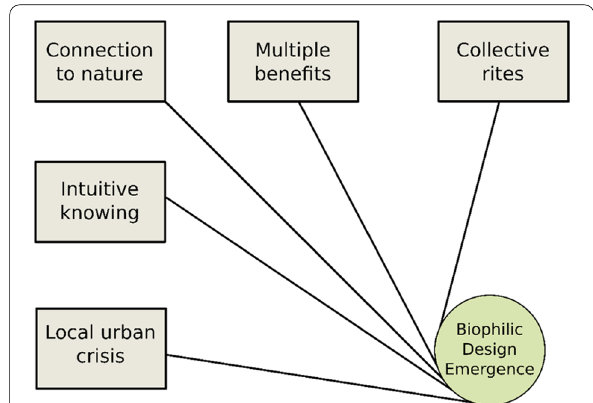
Fig. 2 Prime motivating themes in the emergent stage. (Source